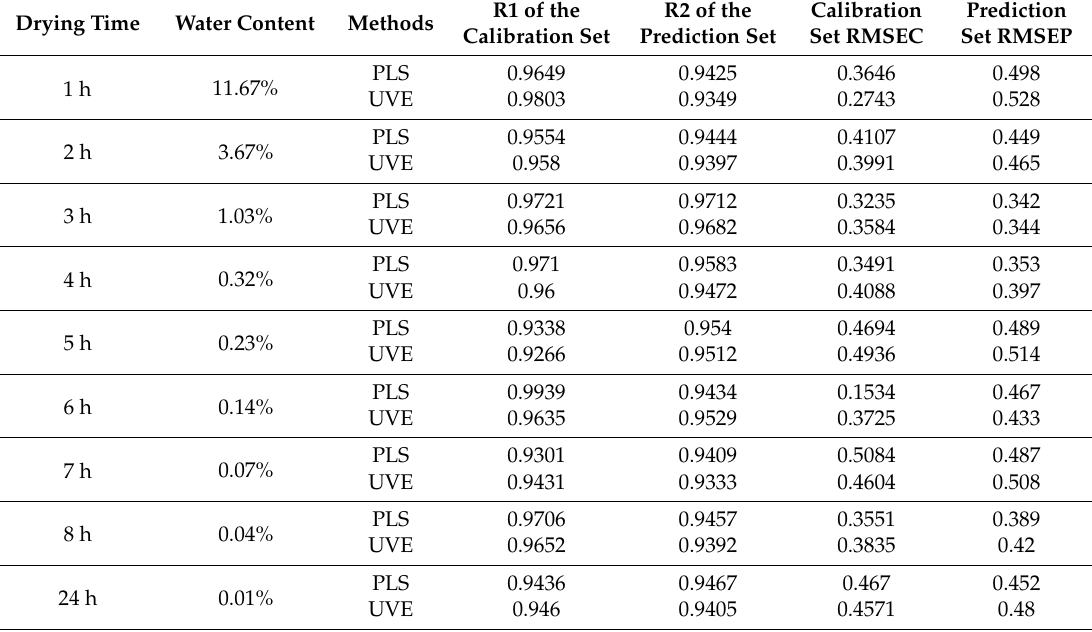
Table 1. Comparison of soil water content and modeling accuracy at different drying time Drying Time Water